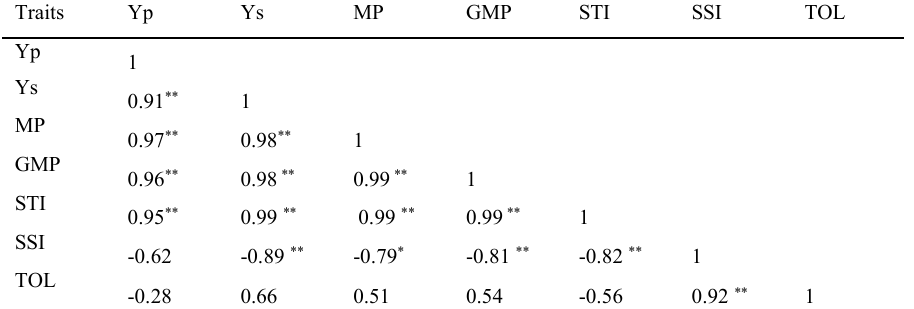
Table 5. Correlation coefficients between studied drought resistance indices in rapeseed (B. napus)